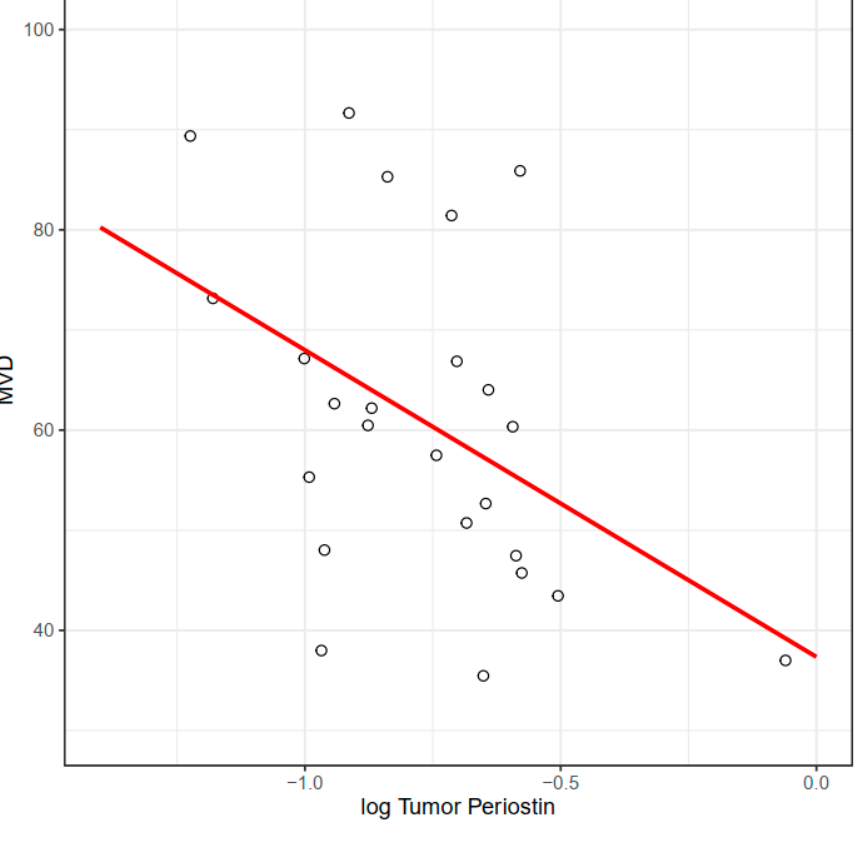
Figure 4. Association between MVD at the invasive front and periostin concentration (R = − 0.44, p = 0.036). R—Pearson’s correlation coefficient. Table 4. Correlation of the periostin concentration with budding.